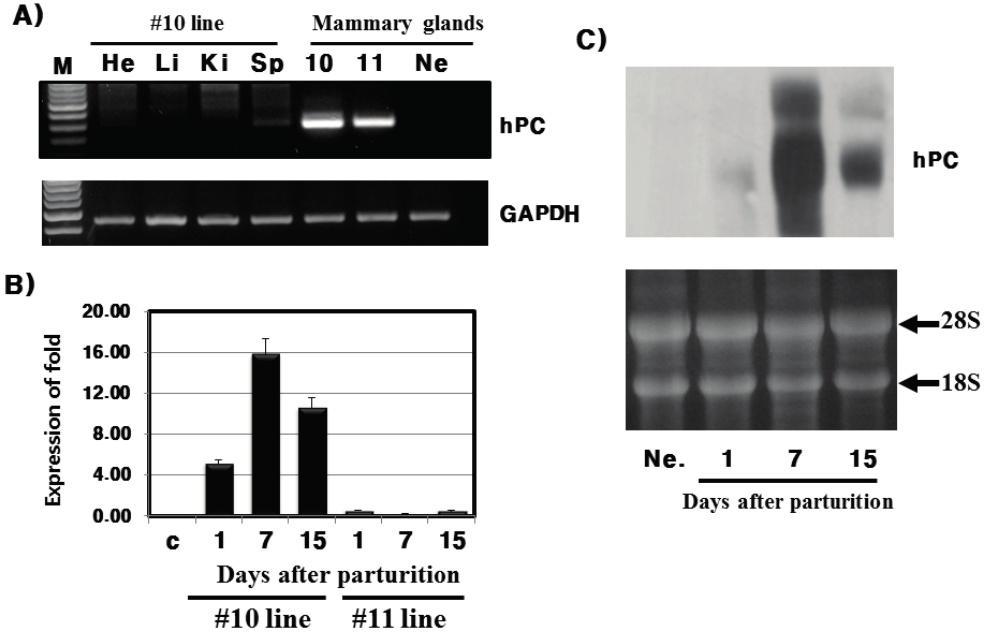
Figure 3. mRNA expression by RT-PCR, qRT-PCR, and Northern blot. ( A ) RT-PCR results from mammary glands and other tissues; ( B ) qRT-PCR results from mammary glands on days 1, 7, and 15 during lactation; ( C ) Northern blot probed with hPC cDNA in the #10 line. M: marker; He: heart; Li: liver; Ki: kidney; Sp: spleen; Ne: negative